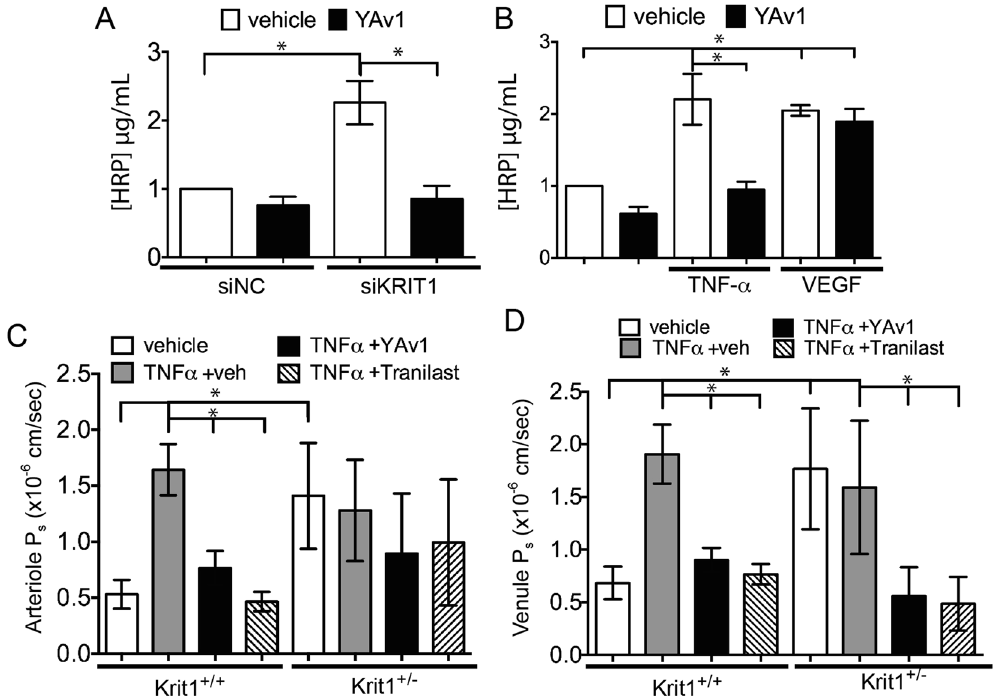
Figure 5. Increased permeability in KRIT1 deficient cells and animals can be reversed by N-(E)-p- coumaroyl-3- hydroxyanthranilic acid. ( A ) HRP leak through HPAEC monolayers transfected with negative control (NC)- or KRIT1-siRNA + / − 100 µ M YAv1. Data shown are the mean HRP concentration, + / − SEM; n = 4. p < 0.001 by ANOVA; * p < 0.05 by Tukey’s post-hoc test. ( B ) HRP leak through HPAEC monolayers treated with 25 ng/ml TNF- α or recombinant human VEGF (50 ng/ml) + / − 100 µ M YAv1. Data shown are the mean HRP concentration, + / − SEM; n = 4. p < 0.001 by ANOVA; * p < 0.05 by Tukey’s post-hoc test. ( C ) and ( D ) Cremaster arteriole ( C ) and venule ( D ) permeability in wild type (Krit1 + / + ) or heterozygous (Krit1 + / − ) mice treated with TNF- α + vehicle, TNF- α + YAv1, or TNF- α + Tranilast. Data shown are the mean P s + / − SEM. n = 9 vessel sites; p = 0.0002 by non-parametric ANOVA; * p < 0.05 by Dunn’s post-hoc